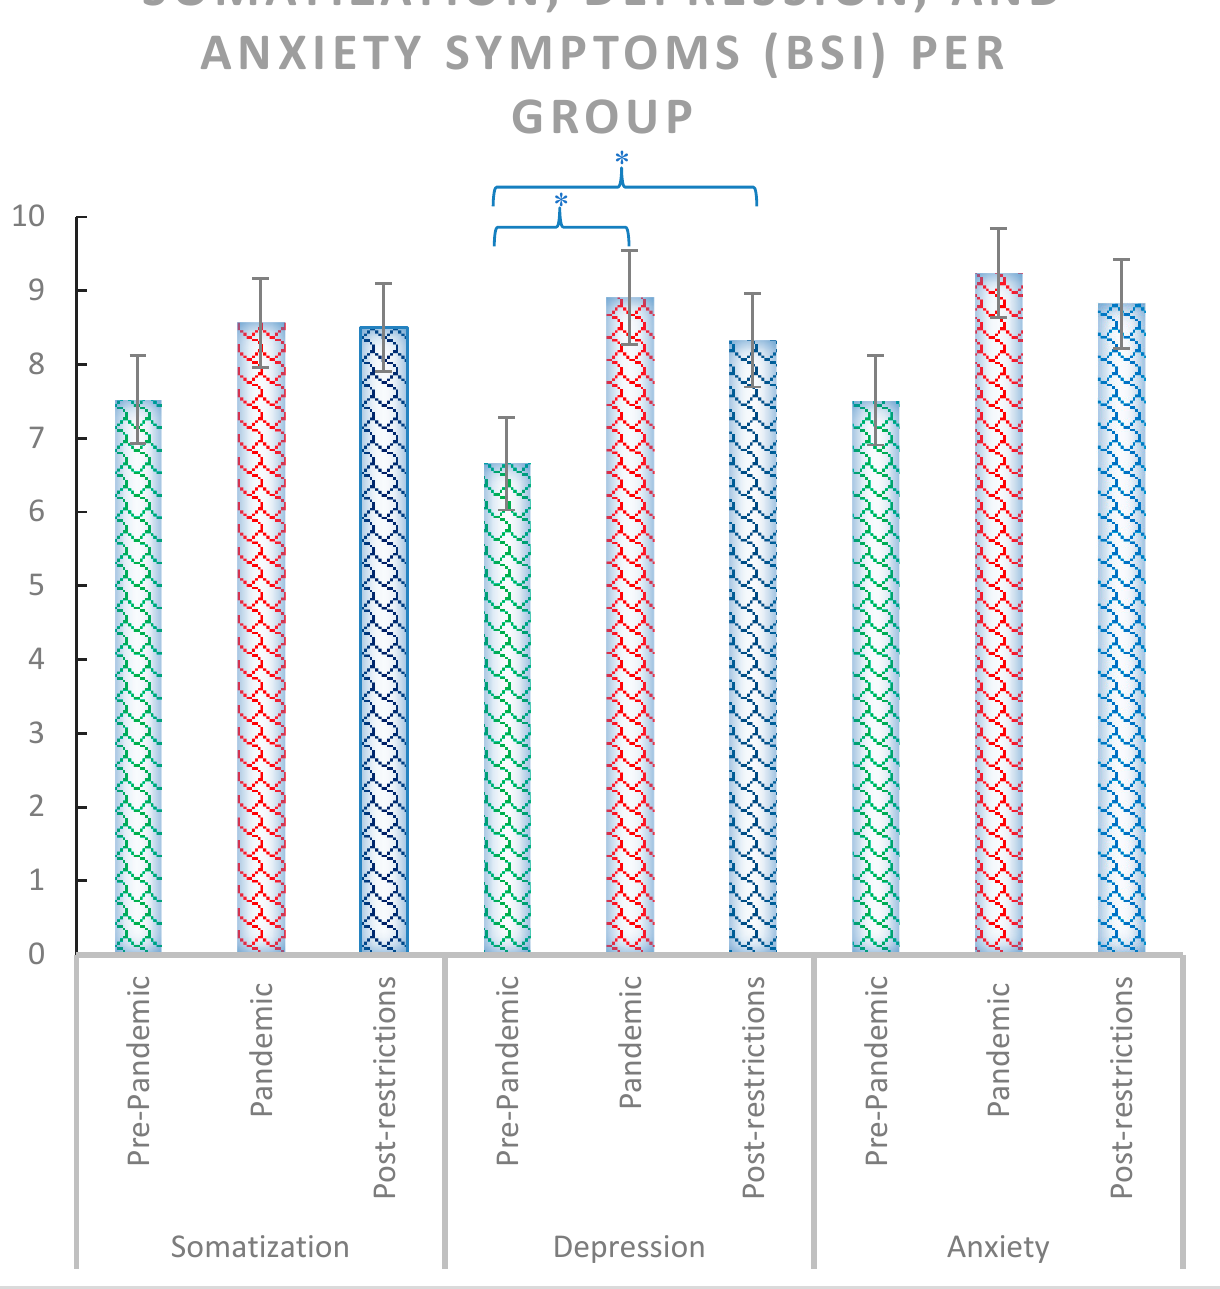
Figure 3. Average scores for somatization, depression, and anxiety symptoms assessed with the BSI-18 questionnaire for pre-pandemic, pandemic, and post-pandemic groups. Where * = p < 0.05. Bars indicate error rates.